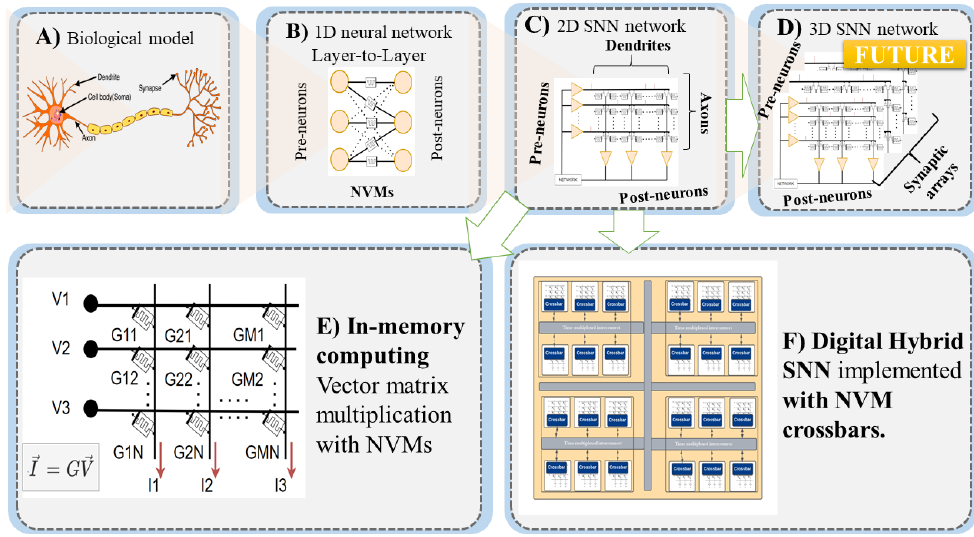
Figure 5. NVM architectures. ( A ) Biological neuron. ( B ) Spiking neural network with spike-based learning implemented through NVMs. ( C ) Crossbar array for spiking neural network. Neuron and dynamic synapse circuits can be integrated into CMOS as in [160]. ( D ) Three-dimensional spiking neural network obtained stacking 2D synaptic arrays. ( E ) Multiplication matrix G is mapped onto NVM crossbar array. Input multiplication vector is defined in the analog domain by voltage vector. The output is the current vector, which represents the vector-matrix product. ( F ) SNN implemented with NVM crossbars that are connected through a time multiplexed interconnect network in a neuromorphic hardware